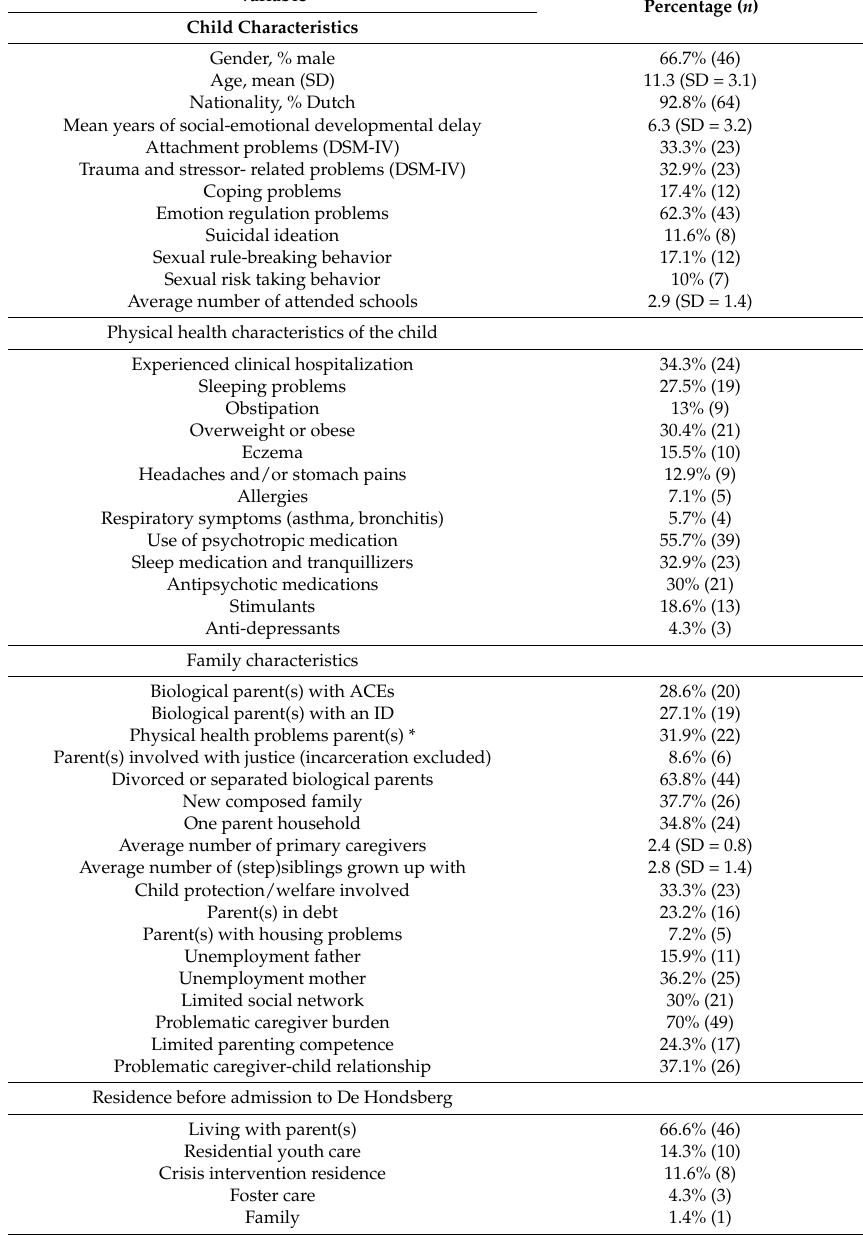
Table 1. Socio-demographic- and other characteristics of the sample group ( n =